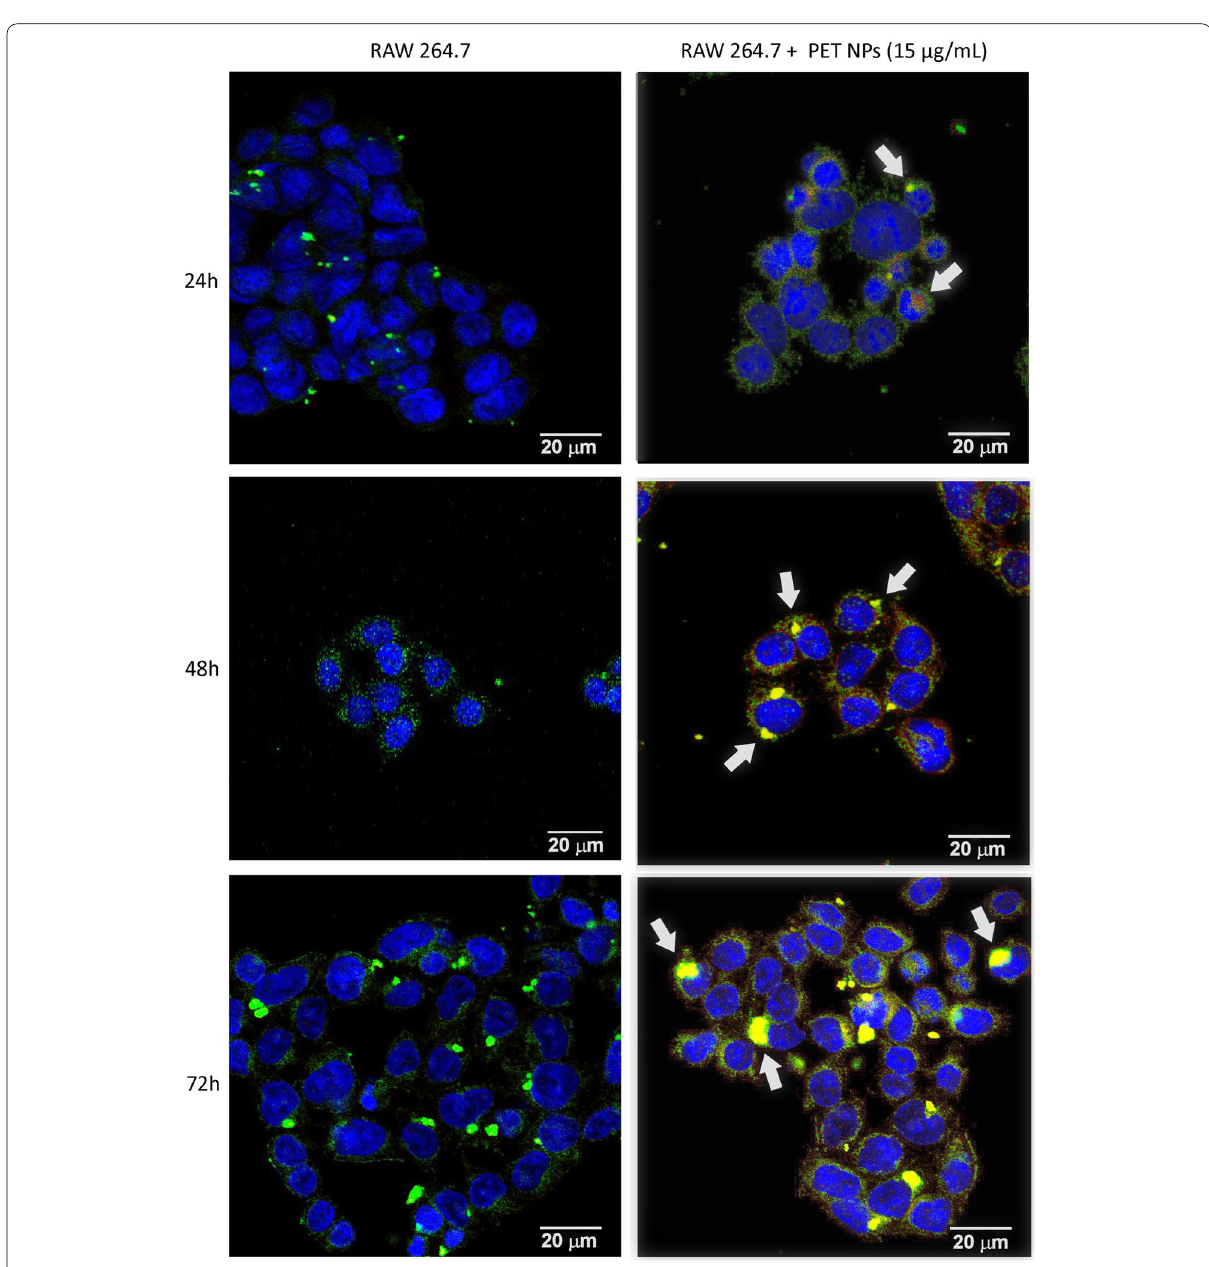
Fig. 3 ROS evaluation by confocal images. Confocal microscopy was applied to determine the ROS production of RAW 264.7 cell line following exposed at 24 h, 48 h, and 72 h at 15 µg/mL PET‑NPs concentration. After 24 h of exposure to 15 µg/mL PET‑NPs, green fluorescence dots were located around the cell nucleus, and the green fluorescence dots and red fluorescence dots exhibited some overlap. Our findings showed significantly high signalling of ROS production in the time. DAPI: cell nucleus (blue), RED NILE: PET‑NPs (red), and DCF: ROS production (green), scale bar 20 =